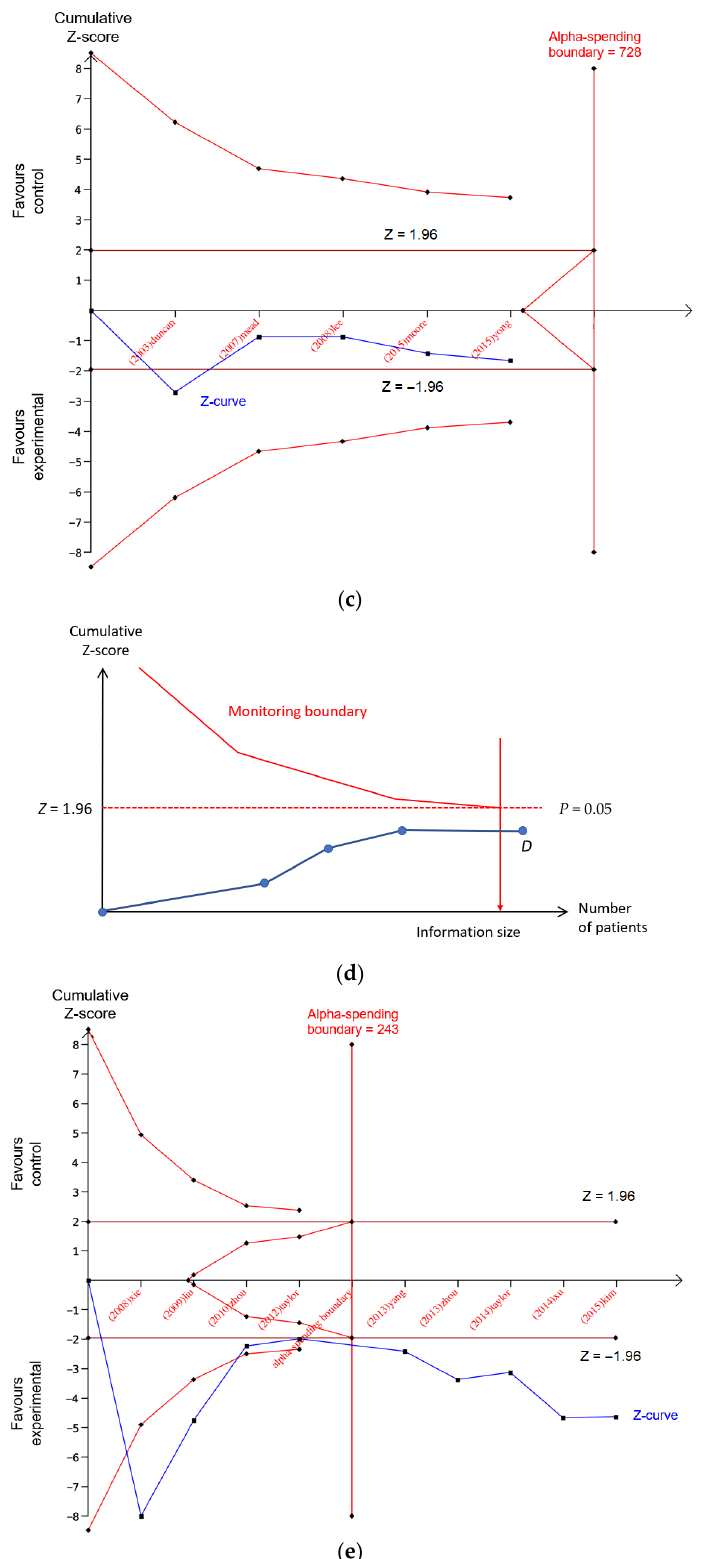
Figure 3. Examples of studies with ( a ) potentially spurious evidence (Pang et al. [22]), ( b ) firm evidence (Bonini-Rocha et al. [23]), ( c ) absence of evidence (Pogrebnoy et al. [24]), ( d ) lack of effects, and ( e ) verified intervention effects (Qin et al.